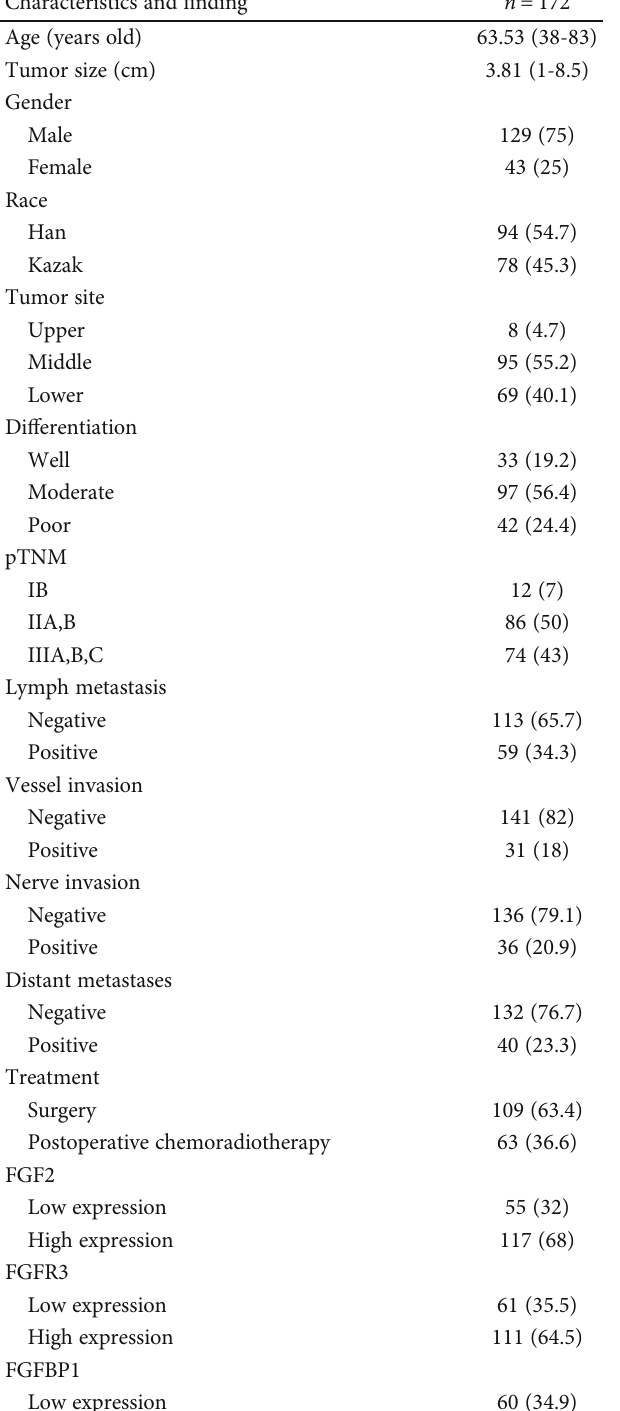
Table 1: Clinicopathological characteristics of esophageal squamous cell carcinoma patients ( n (%)).